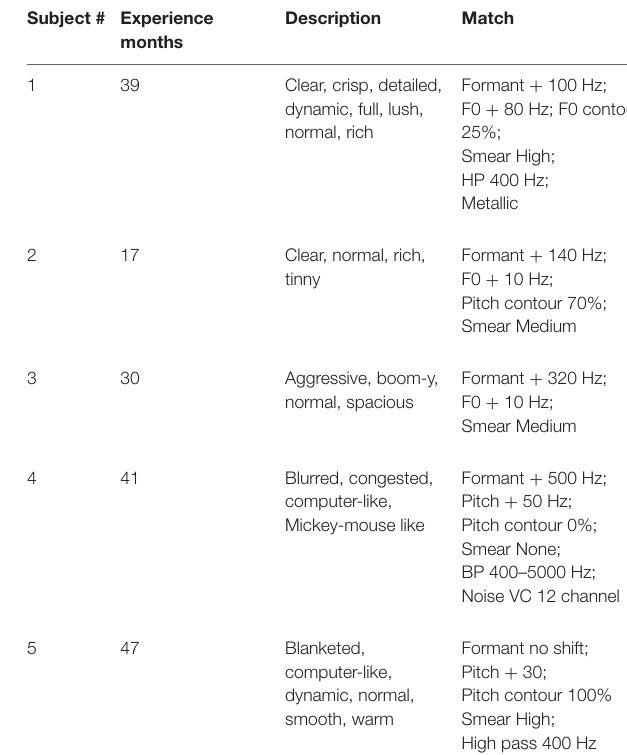
TABLE 4 | Sound quality descriptions and sound quality matches at Time